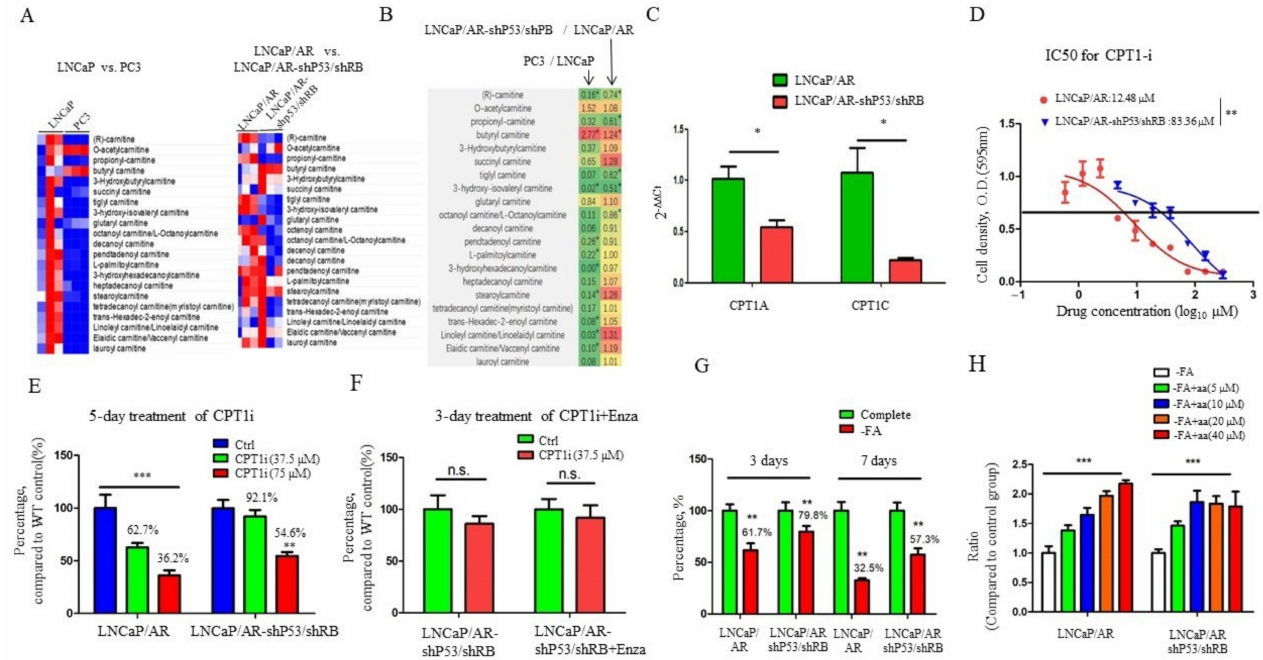
Figure 2. Fatty acid oxidation (FAO) is downregulated in NE-like prostate cancer cells. ( A ). Heatmap for fatty acyl- carnitines in NE-like PCa cell lines (PC3 and LNCaP/AR-shP53/shRB cells) versus adenocarcinoma PCa cells (LNCaP and LNCaP/AR). Fatty acyl-carnitines are mostly decreased in NE-like PCa cells compared to the adenocarcinoma cells. ( B ). Fatty acyl-carnitine changing folds in PC3/LNCaP and LNCaP/AR-shP53/shRB/LNCaP/AR cells. Green: ratio upregulated, red: ratio downregulated. ( C ). CPT1A and CPT1C mRNA levels in LNCaP/AR and LNCaP/AR-shP53/shRB cells. Both CPT1 isoforms are decreased in LNCaP/AR-shP53/shRB cells significantly. ( D ). IC50 of CPT1 inhibitor in different cell lines. NE-like PCa cell line LNCaP/AR-shP53/shRB displays decreased IC50 value of CPT1 inhibitor. ( E ). Cell number changes in LNCaP/AR and LNCaP/AR-shP53/shRB cells after 5-day treatment of CPT1i. ( F ). Cell number changes in LNCaP/AR-shP53/shRB cells after 3-day treatment of enzalutamide (20 uM) combined with CPT1i. ( G ). Cell number changes in LNCaP/AR and LNCaP/AR-shP53/shRB cultured with complete media or FA depleted medium for 3 days or 7 days. ( H ). Arachidonic acid (AA)’s effect on the proliferation of LNCaP/AR and LNCaP/AR-shP53/shRB cells. LNCaP/AR-shP53/shRB cells present more sensitivity to AA supplement. For all panels unless otherwise noted, mean ± SEM (error bars) is represented, and p values were calculated using t tests. N.S., not significant. * p < 0.05, ** p < 0.01, *** p <